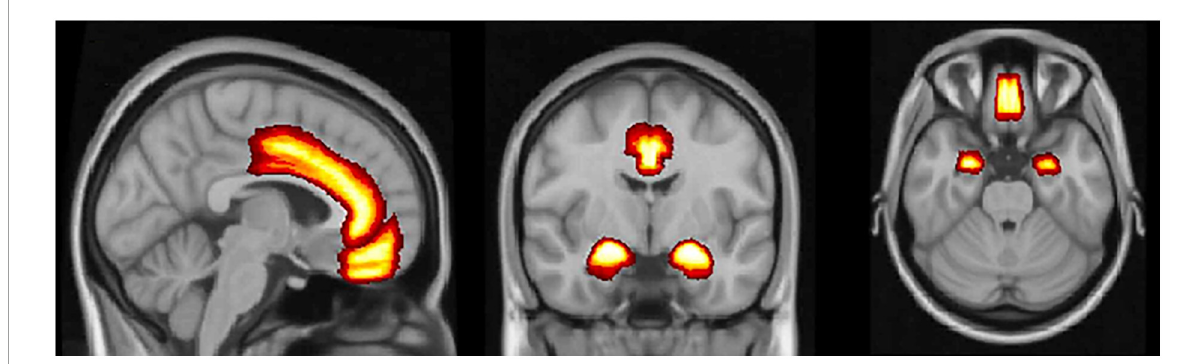
FIGURE2 The medial prefrontal cortex, the anterior cingulate cortex, and amygdala. Brain regions with the most consistent neuroimaging and metabolic findings that differentiate women with postpartum depression from healthy controls.